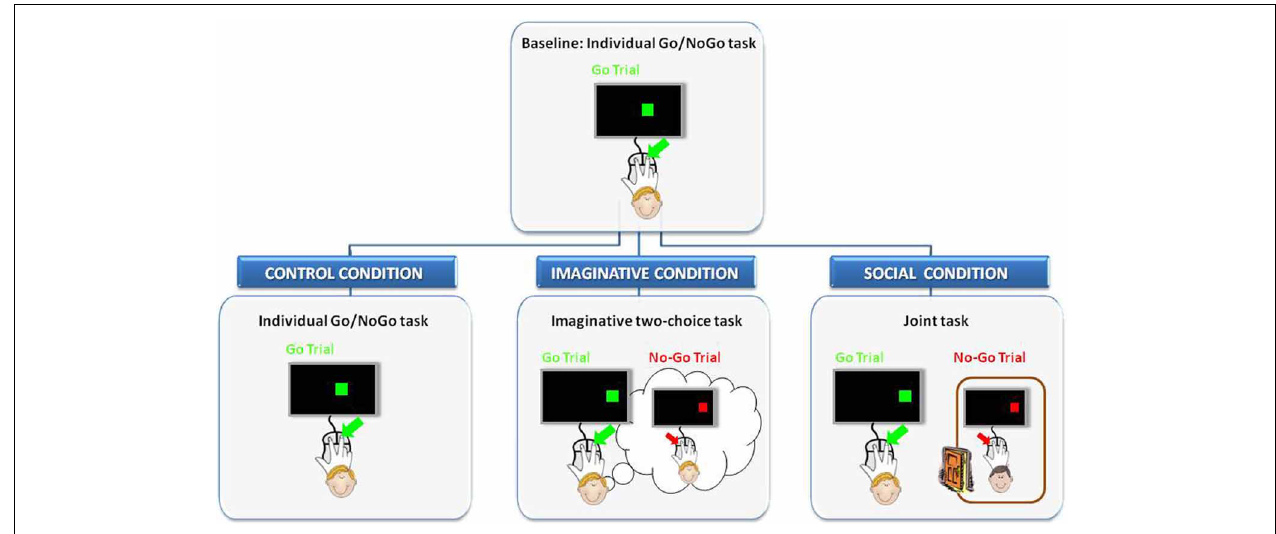
FIGURE 1 | Schematic representation of the experimental design adopted in Experiment 1. Participants were randomly assigned to one of three experimental conditions: control, imaginative or social. Each experimental condition comprised two tasks (i.e., the baseline individual task and the critical task). Participants assigned to the control condition, after completed the baseline, simply continued to perform the same Go/NoGo